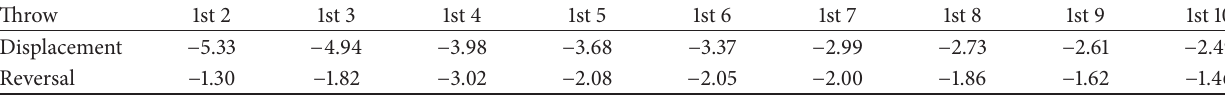
Table 1: Adaptation slopes during displacement and reversal adaptation phase.